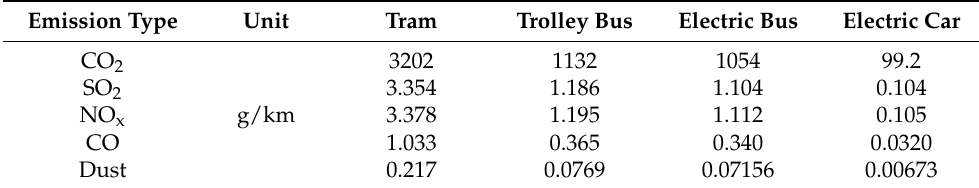
Table 8. The amount of emitted compounds during production of electric energy that are needed for each transport mode to cover a distance of 1 km.